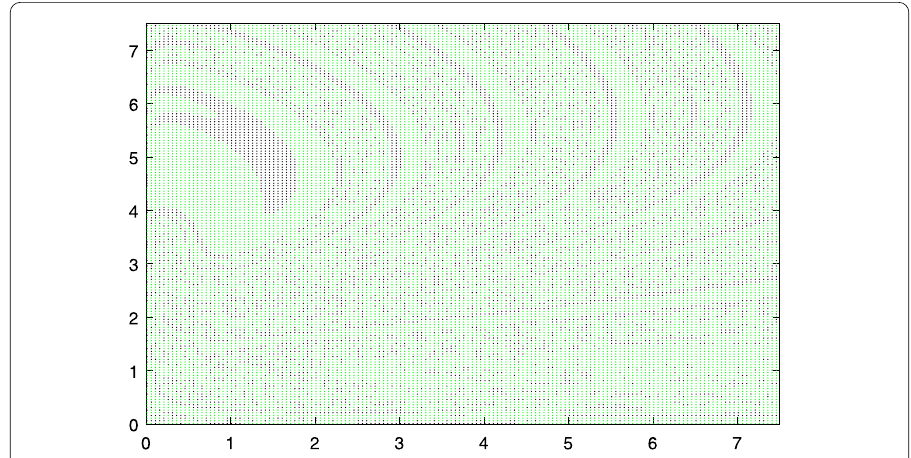
Figure 6 Basin of attraction of the two attractors of model (17) with the parameters identical to those in Fig. 4. The blue and green points are attracted to the attractors shown in Fig. 5 from top to bottom, respectively